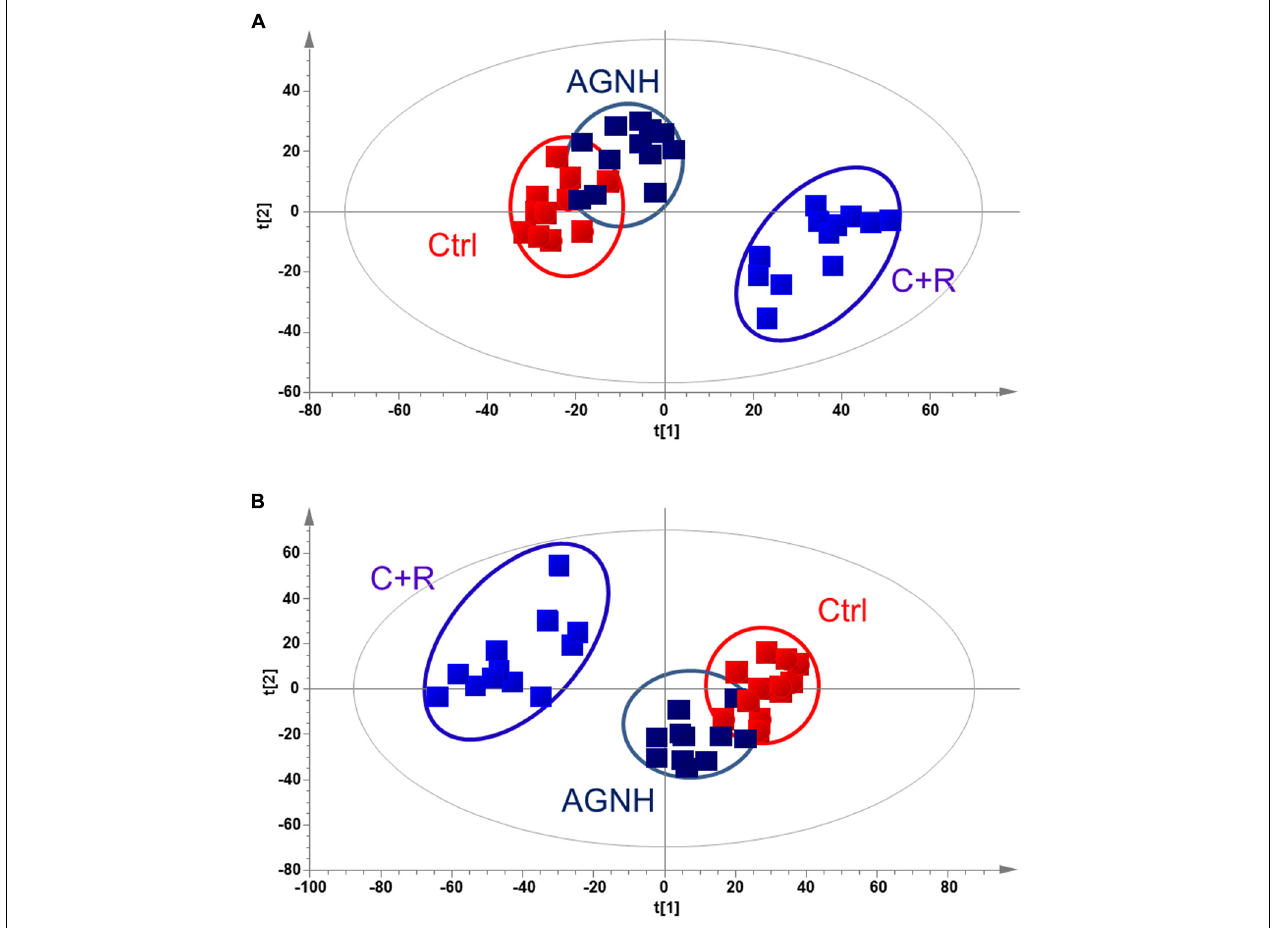
FIGURE 4 | PLS-DA score plot of saline control (Ctrl), An-Gong-Niu-Huang Wan (AGNH) and cinnabar and reaglar co-administration (C+R) groups based on the serum metabolic profiles for (A) positive ( R 2 X = 0.416, R 2 Y = 0.968, and Q 2 = 0.874) or (B) negative ( R 2 X = 0.743, R 2 Y = 0.950, and Q 2 = 0.722)